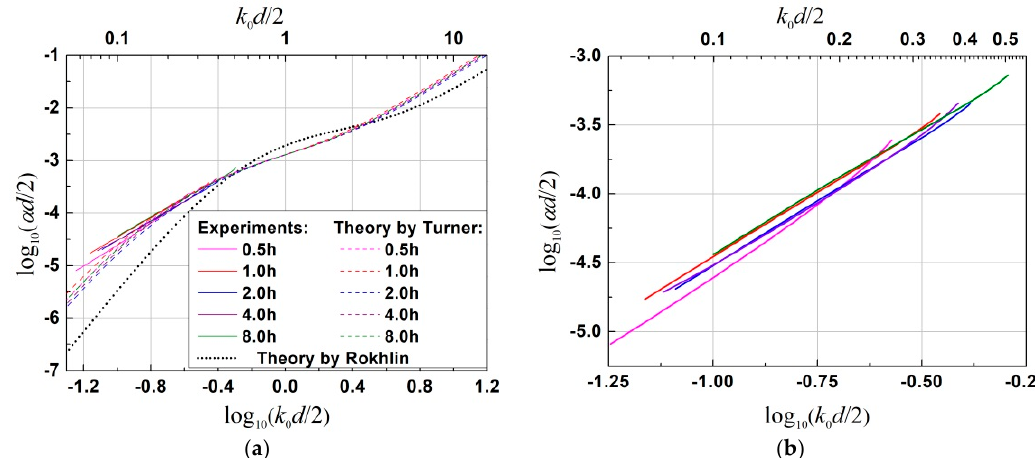
Figure 10. ( a ) Comparison in attenuation coefficient versus frequency by using the logarithmic scale, log 10 ( α D /2) vs. log 10 ( k 0 D /2), between experimental estimations and two different theoretical models: (i) the Rokhlin’s model [16] considering a single mean grain size, and (ii) the improved Turner’s model [22] incorporating a log-normal distribution of grain sizes, for a longitudinal wave in α -titanium alloy annealed at 800 ◦ C after different holding times. ( b ) Zoom-in on experimental data for all the specimens that are roughly superposed. (Color online).